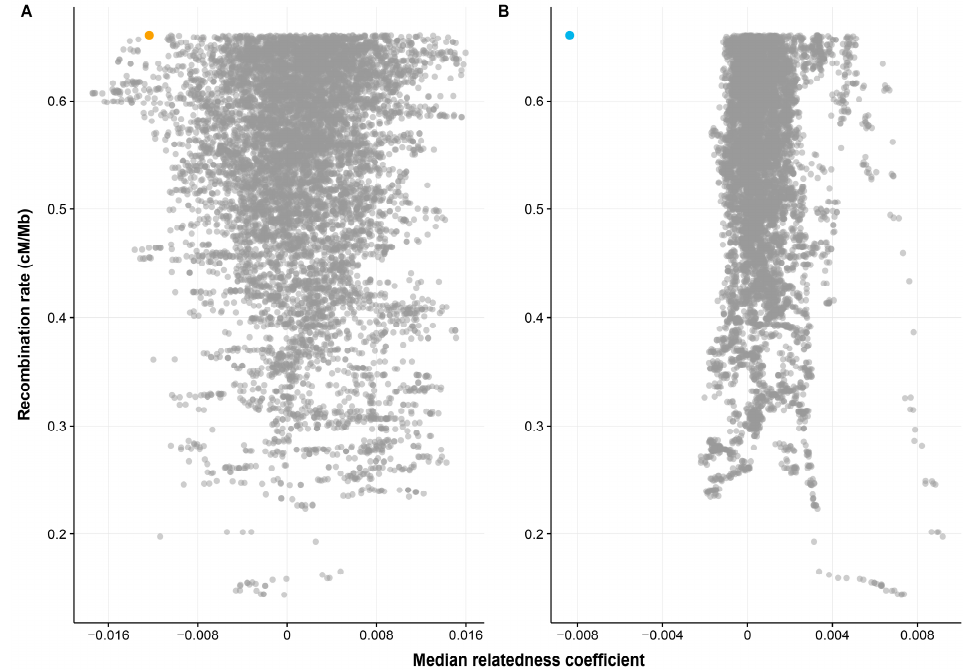
Figure 2. Median relatedness coefficients for the sampled 4.97 Mb genomic regions ( N = 10,000) across the genome between ( A ) spouses ( B ) opposite-sex non-spouse pairs. Each grey dot represents one sampled genomic region. The MHC region for spouses and non-spouse pairs were plotted in yellow (in A ) and blue (in B ), respectively. The outlying points in the right hand side of panel B represent overlapping windows from the same genomic region of chromosome 3p- an area of particularly high linkage disequilibrium and low recombination.